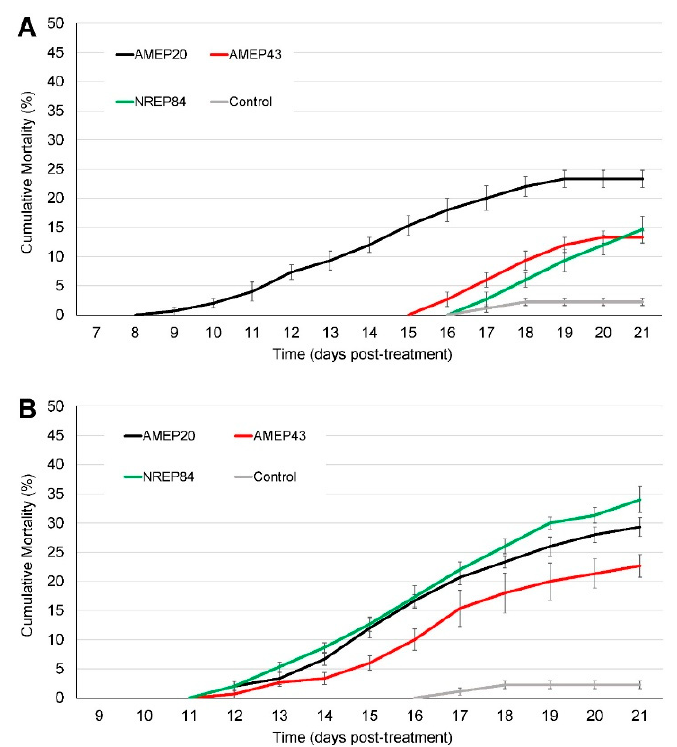
Figure 2. Mean cumulative mortality data (%) with standard errors of Hylobius abietis adults after their inoculation with conidia suspensions of Beauveria strains at concentrations of 1 × 10 6 conidia mL − 1 ( A ) and 1 × 10 7 conidia mL − 1 ( B ).